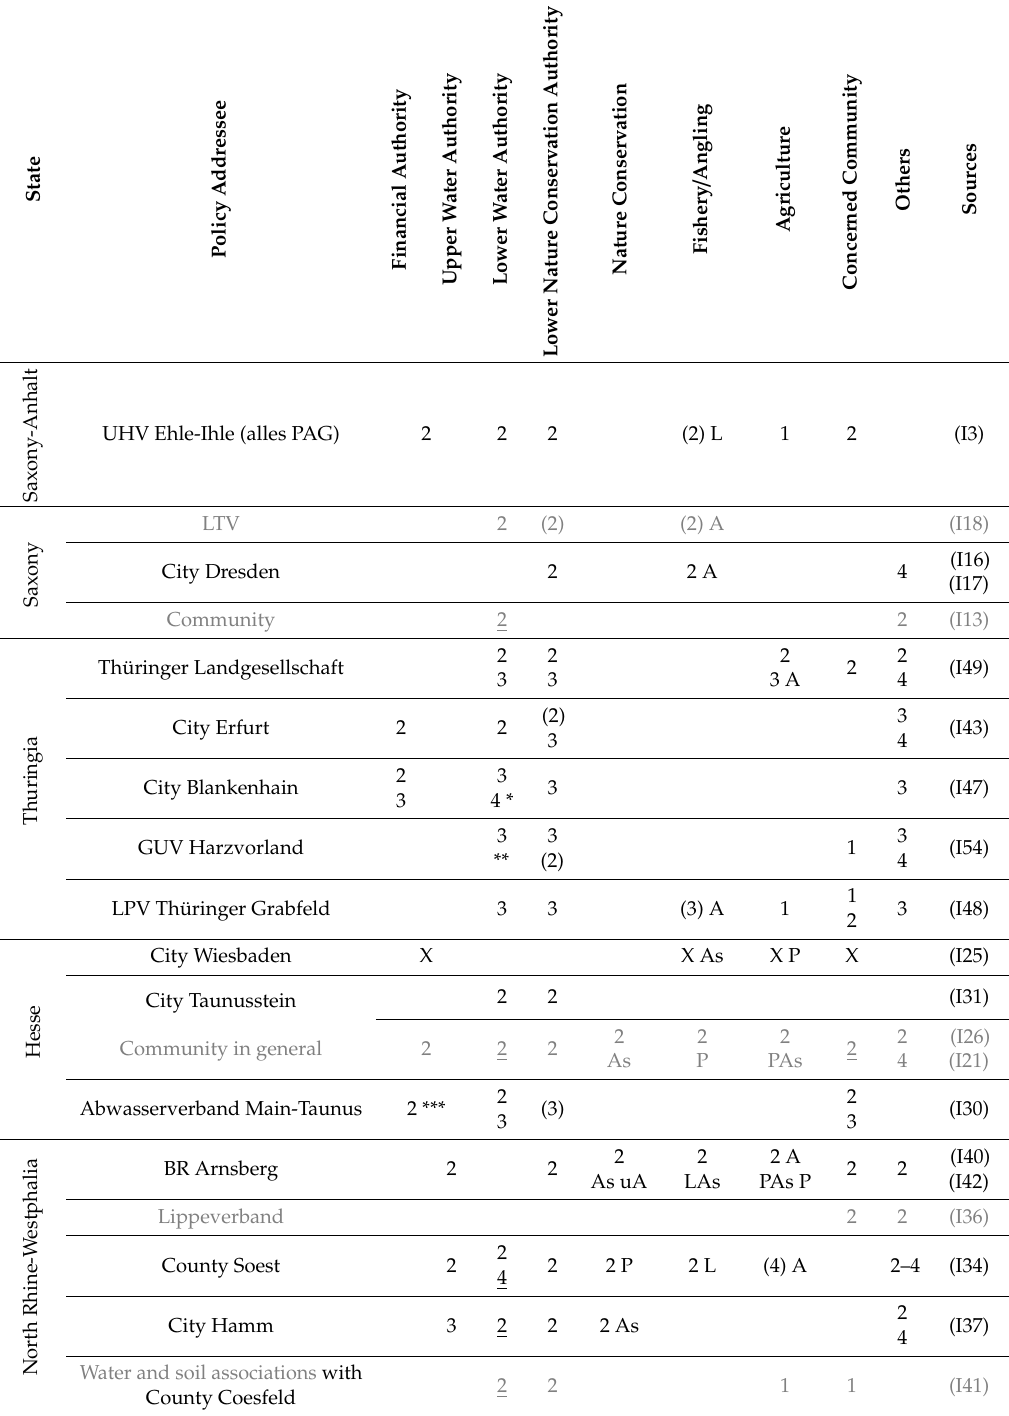
Table A7. Involved in integration attempts (own category for a minimum of four